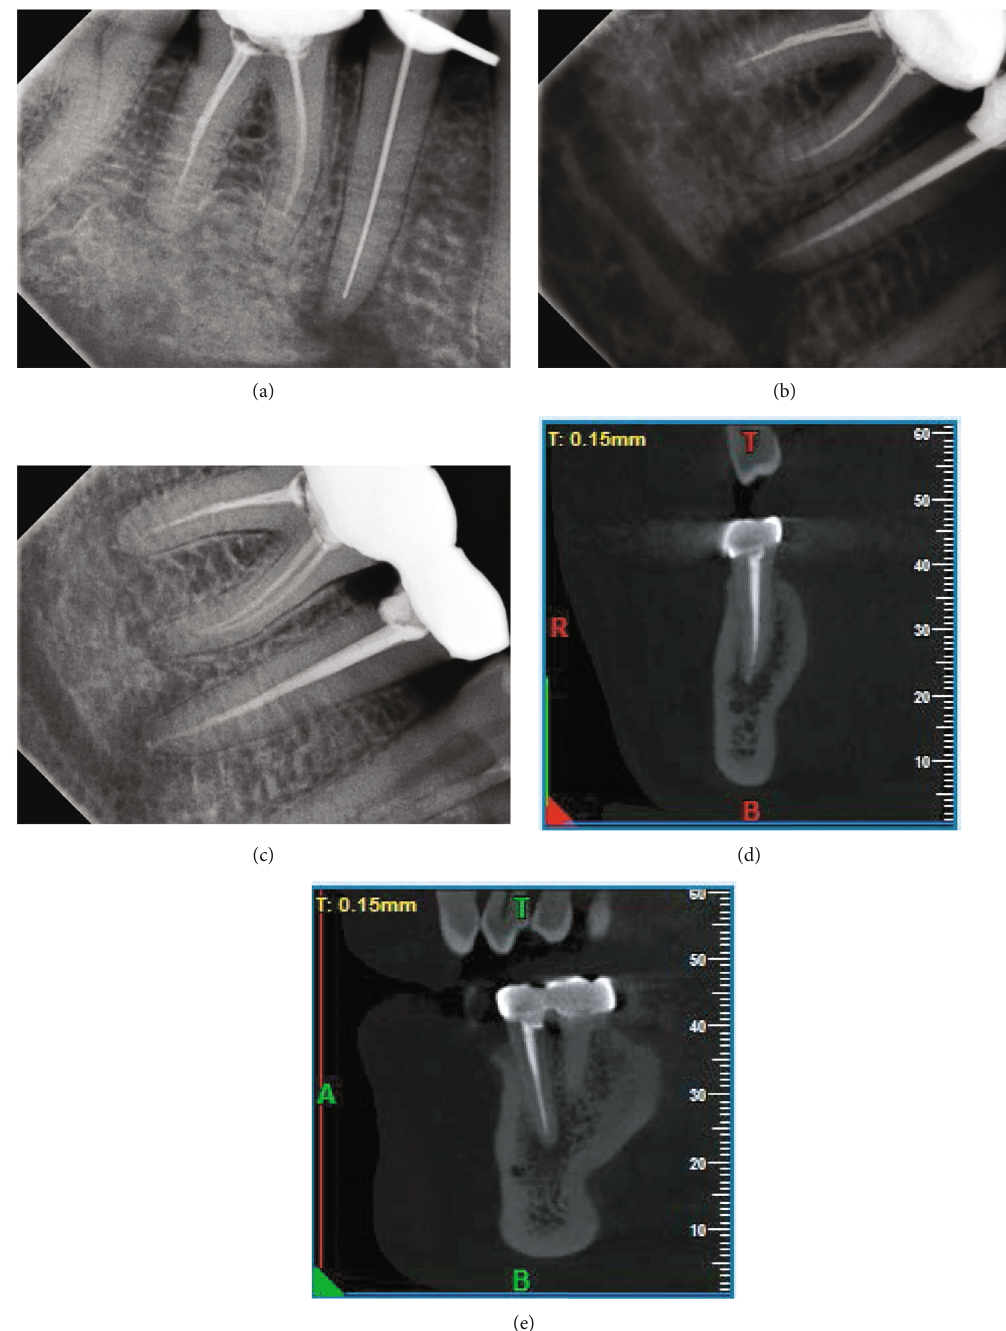
Figure 4: (a) Working length determination, (b) obturation, (c) 3-month follow-up RVG, and (d, e) 12-month follow-up